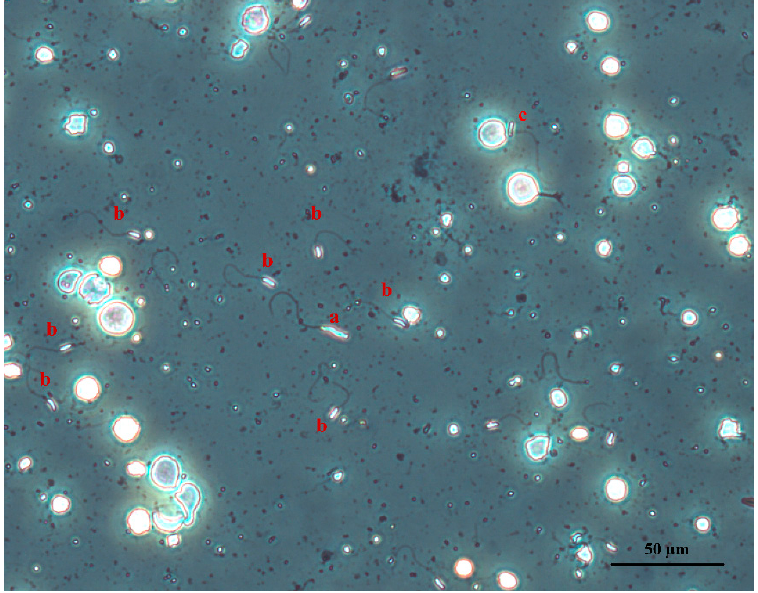
Figure 2. Sperm defects determined in peregrine falcon semen samples. Macrocephalic sperm (a), normal sperm (b), midpiece defect (c) (×20).